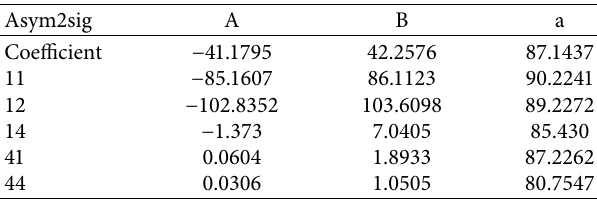
Figure 8: Brightness comparison statistics in different directions. (a) Brightness comparison chart in the X direction. (b) Brightness comparison chart in the Y direction. Table 2: The function fitting coefficient table of the brightness value of each oil paint color block changing with the illumination angle.